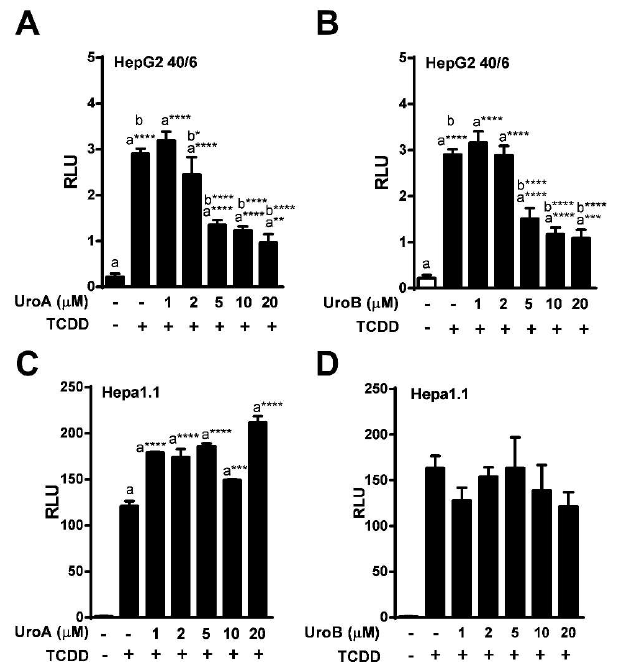
Figure 3. Dose-response assessment of AHR antagonism by UroA and UroB. HepG2 (40/6) reporter